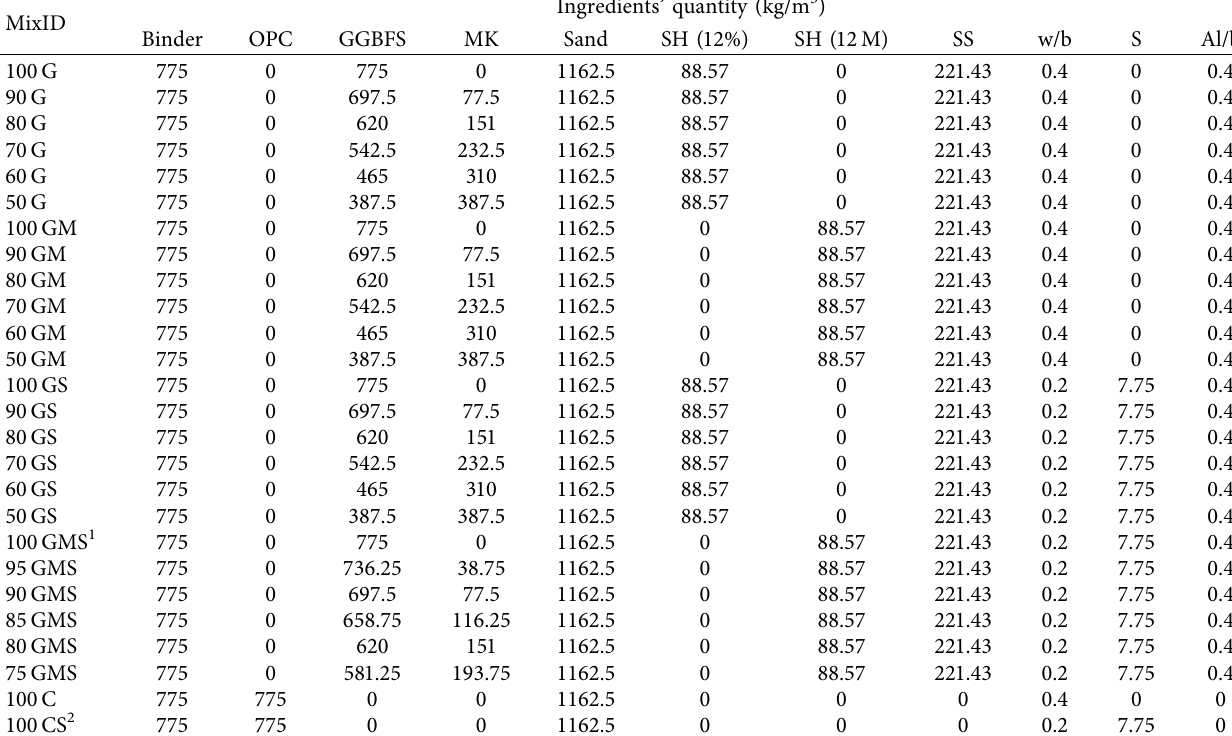
Ingredients’ quantity (kg/m 3 )